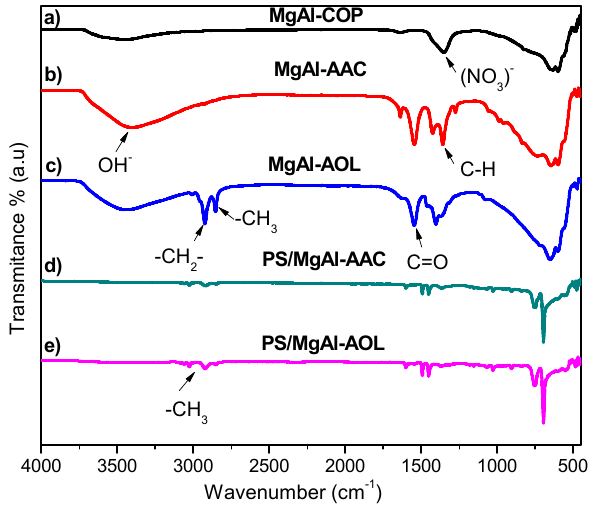
Figure 5. Fourier transform infrared spectroscopy (FTIR) spectra of: ( a ) MgAl-COP, ( b ) MgAl-AAC, ( c ) MgAl-AOL, ( d ) PS/MgAl-AAC, and ( e ) PS/MgAl-AOL.